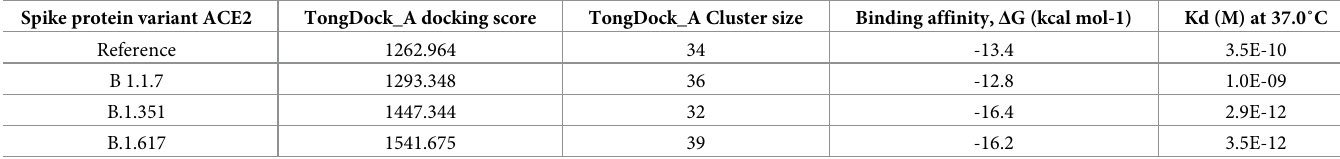
Table 1. Results of molecular docking between SARS-CoV-2 spike glycoprotein Receptor Binding Domain (RBD) and human ACE2 receptor. The binding affinity was measured in physiological temperature (37˚C). Spike protein variant ACE2 Kd (M) at